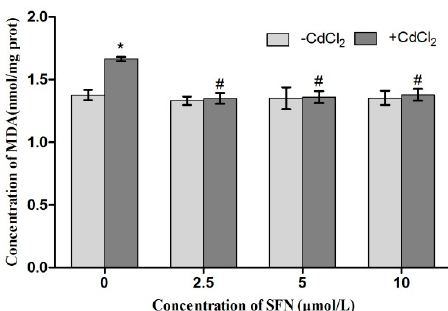
Figure 13. Content of MDA in TM3. * represent a significant difference, respectively, compared with the control group. # represent a significant difference compared with the Cd group.